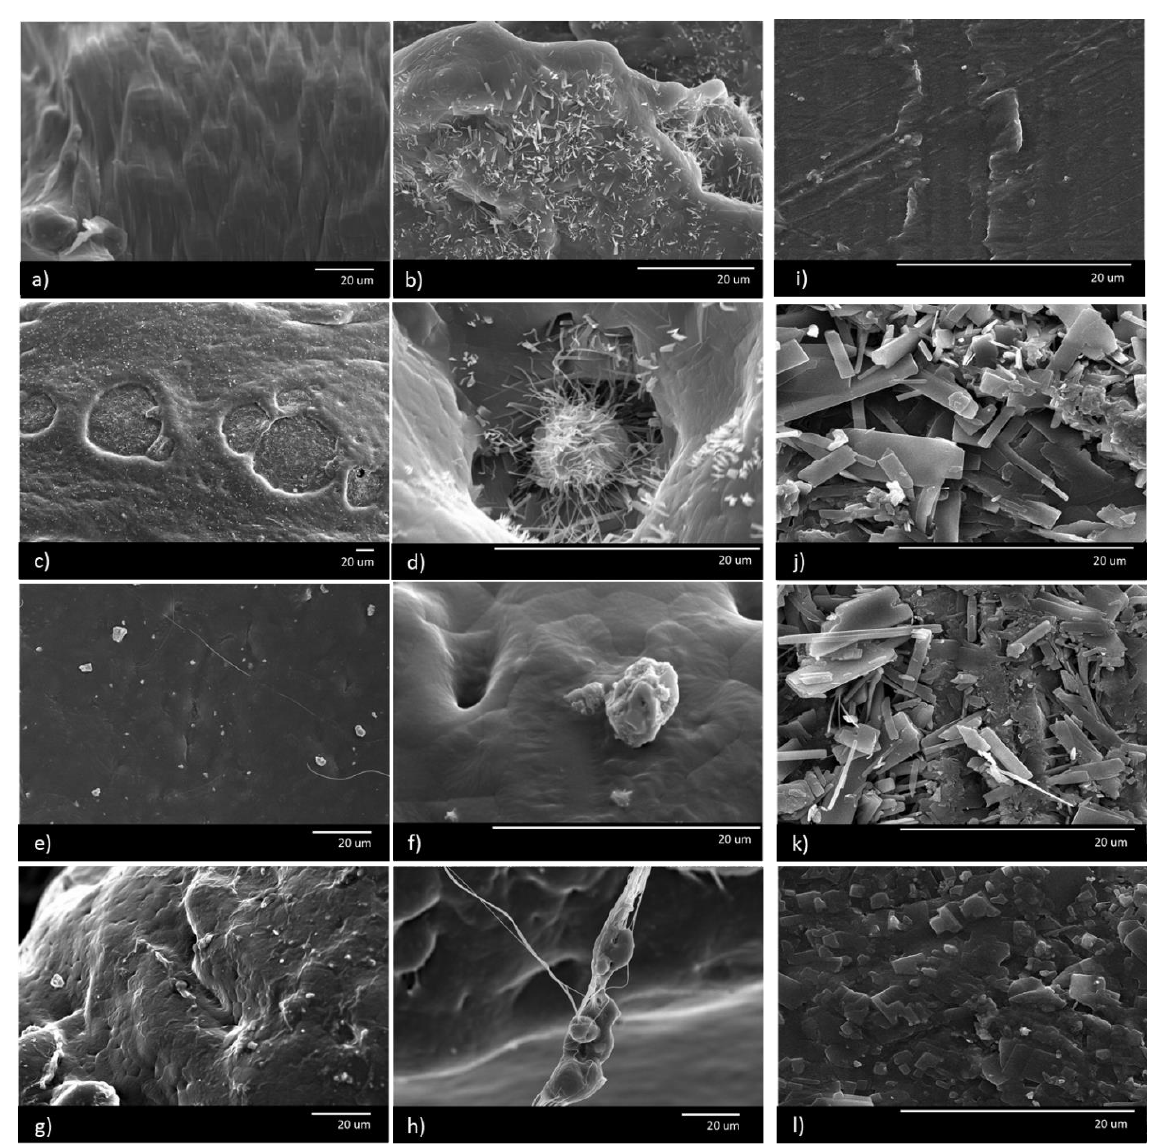
Figure 2. SEM—W0 (left—( a , c , e , g )—and central—( b , d , f , h )—columns) and W4 (right column— i , j , k , l ). ( a ): F1; ( b ): F3; ( c ): F9; ( d ): F13; ( e , f ): F5; ( g , h ): F4; ( i ):F1; ( j ): F3; ( k ): F9; ( l ) F10.